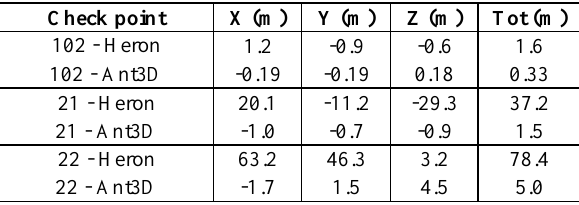
Table 5. Accuracy check on RTK GNSS points for both the tested systems. In the table, “Heron” abbreviates “Heron MS Twin